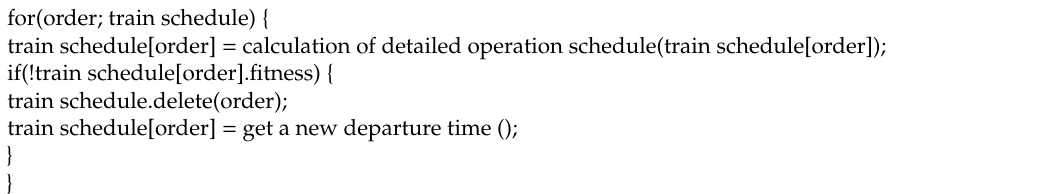
Table 12. Pseudocode for repair [6].